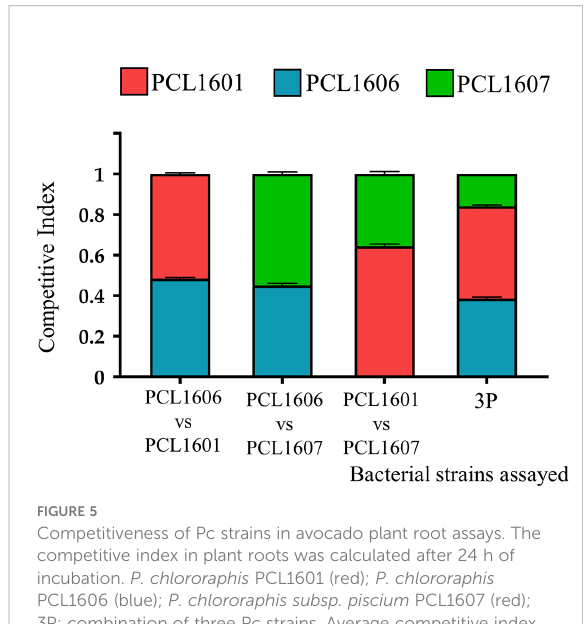
BA FIGURE 6 Time course of the bacterial counts of Pc strains inoculated in avocado roots (A) individually and (B) in triple combination (3P). P. chlororaphis PCL1601 (red); P. chlororaphis PCL1606 (blue); P. chlororaphis subsp. piscium PCL1607 (green). Bacterial counts and standard error (error bars) of three independent experiments are